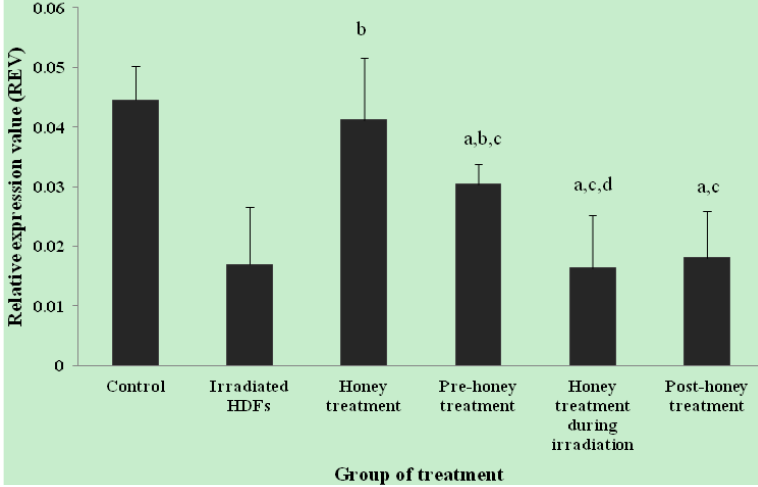
Figure 1. Expression of SOD1 gene in different HDFs treatment groups. HDFs were pre-, during- and post-treated with 6 mg/mL of Gelam honey for 24 h and exposed to 1 Gy of gamma rays. Results are expressed as means + S.D (n = 6). a Denotes p < 0.05 compared to untreated control, b p < 0.05 compared to irradiated HDFs, c p < 0.05 compared honey